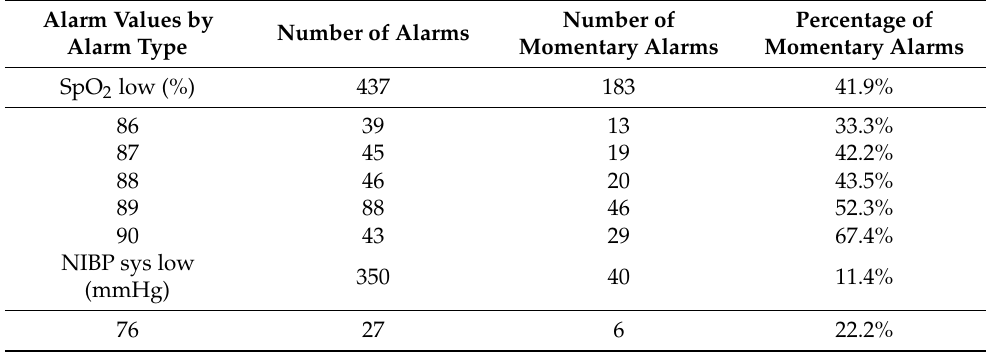
Table 2. Alarm values (initial) and the corresponding number of